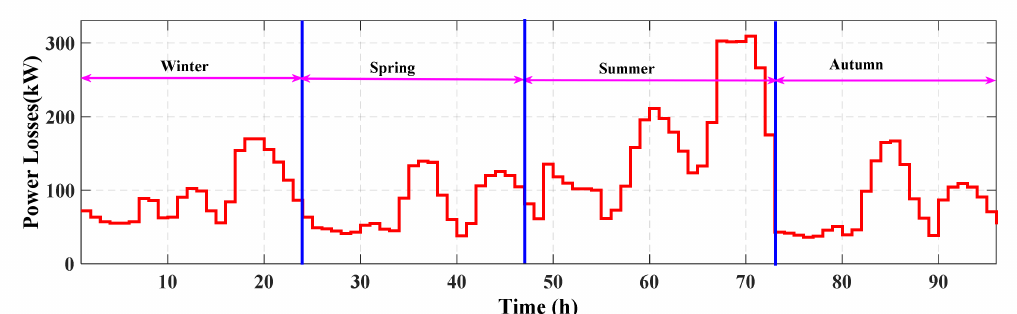
Figure 5. The power losses of the